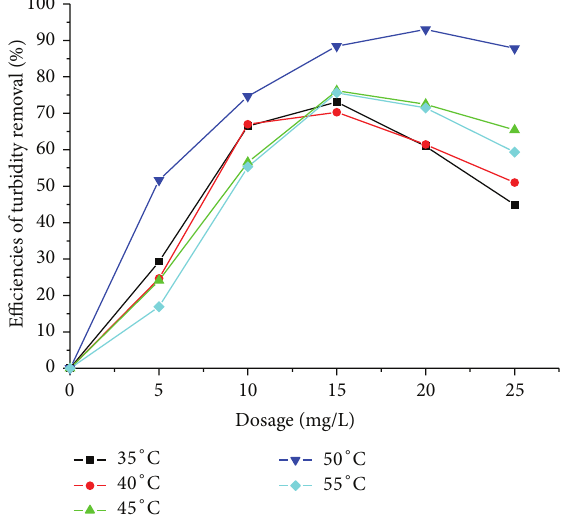
Figure 14: Effects of ratio of monomers on intrinsic viscosity and rates of